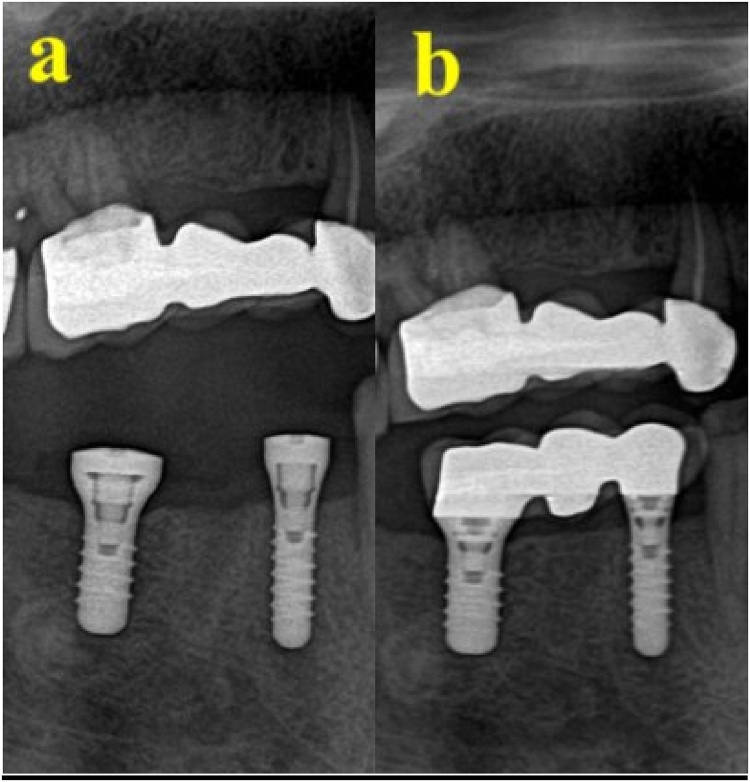
(A) Two implants inserted in the premolar-molar area before loading. (B) Implants are loaded with a bridge, replacing the premolar area.